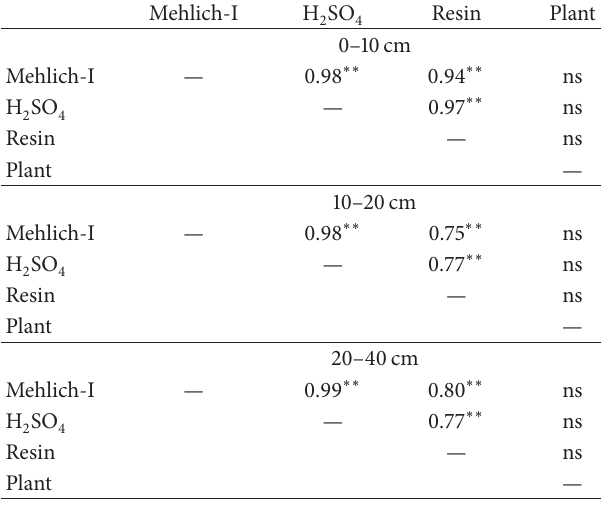
Table 6: Correlation matrix for phosphorus extracted from soils at depths of 0–10, 10–20, and 20–40 cm and phosphorus levels in diagnostic leaves of sugarcane plants grown in those soils, for the short-term experiment ( 𝑛 = 4